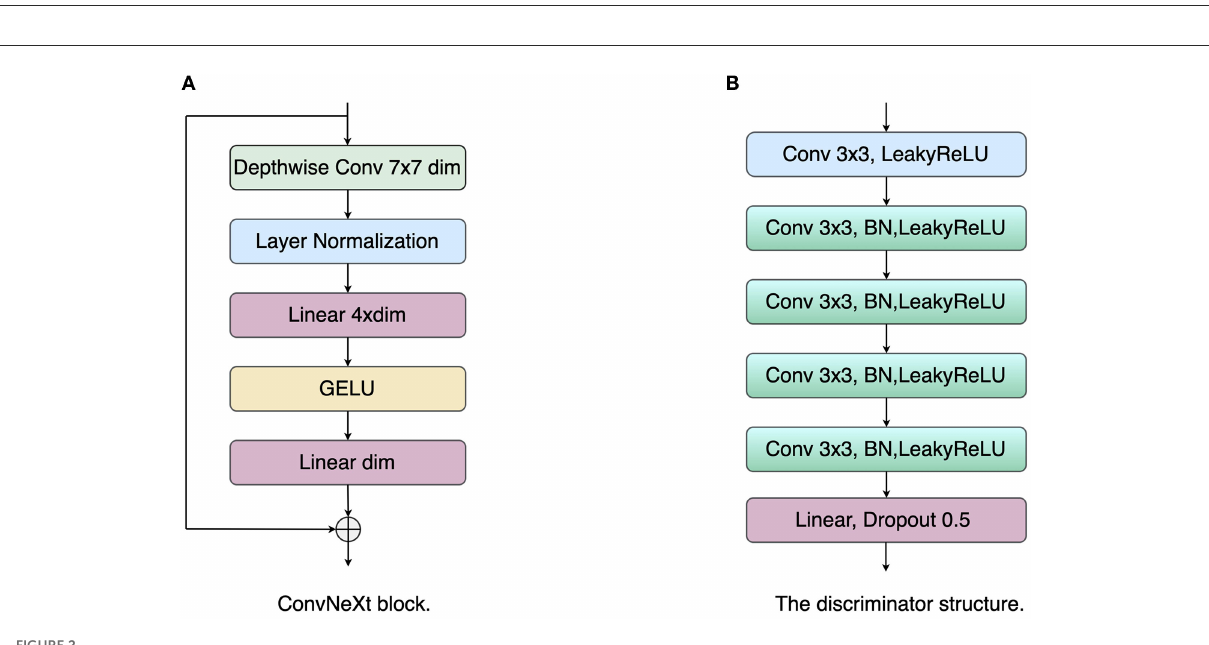
ConvNeXt adjusts the number of blocks in each stage of ResNet-50 to (3, 3, 9, 3). In the first layer of the network, the Stem convolution layer in the Transformer with a step size of 4 and a kernel size of 4 is employed to downsample the input image. In each convnext block, the network introduces a deeply separable convolution module,